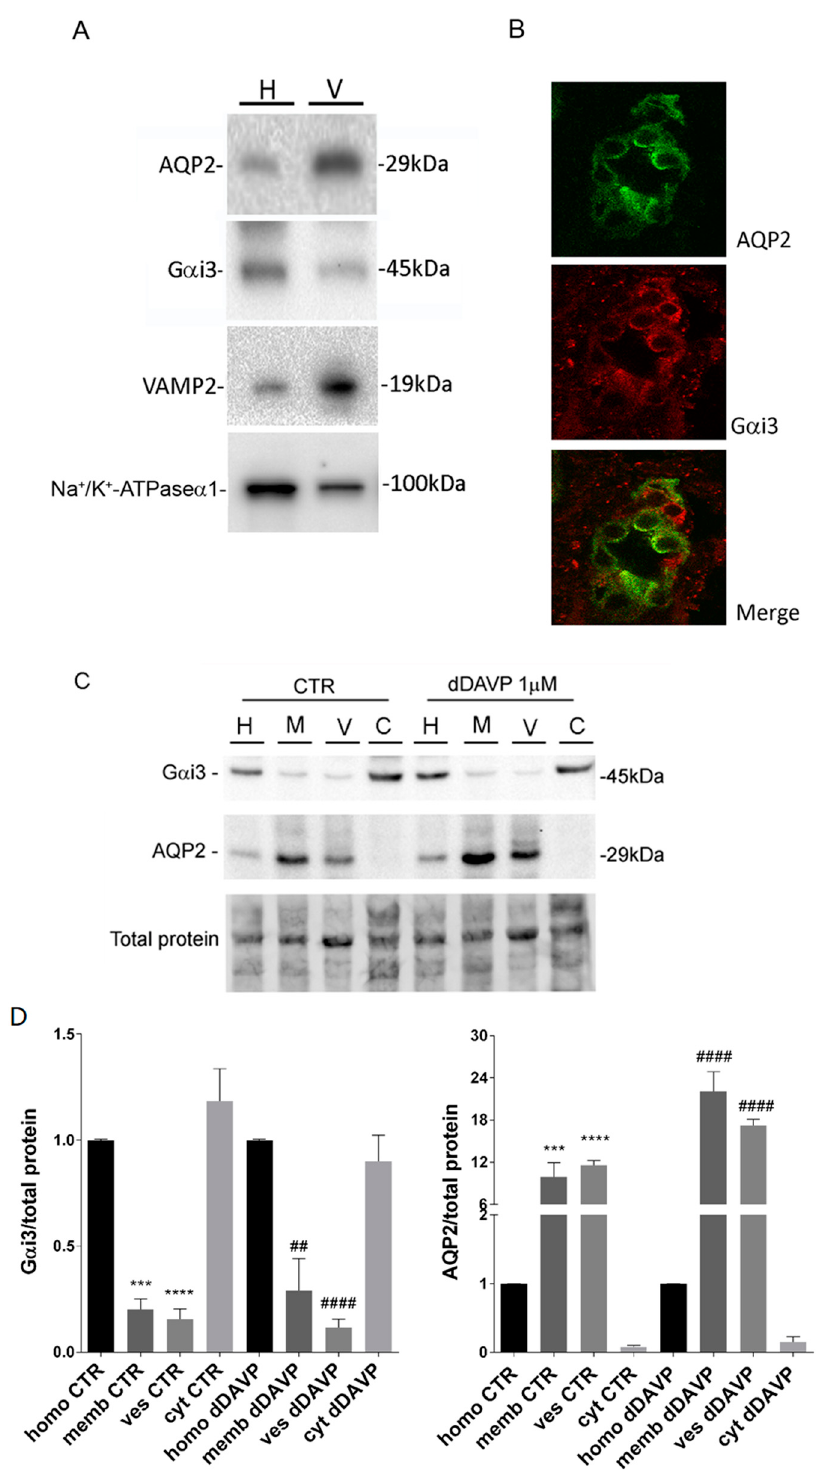
Figure 2. Heterotrimeric G protein G α i3 is associated with AQP2 vesicles isolated from rat kidney medulla. ( A ) Expression of AQP2, G α i3, Vamp2 and Na + /K + -ATPase in rat kidney medulla homogenate and AQP2 vesicles isolated from rat kidney medulla. 30 µg of protein from total rat homogenate (H) or purified AQP2 vesicles from rat inner kidney medulla (V) were blotted and probed with indicated antibodies. AQP2 is found highly enriched in the vesicle fraction along with the vesicle marker VAMP2, with low contamination by plasma membranes tested using the marker Na + /K + -ATPase α 1. G α i3 appears to be expressed both in total homogenate and in vesicles fraction. Western blot is representative of 3 experiments. ( B ) Localization of AQP2 and G α i3 in rat kidney.